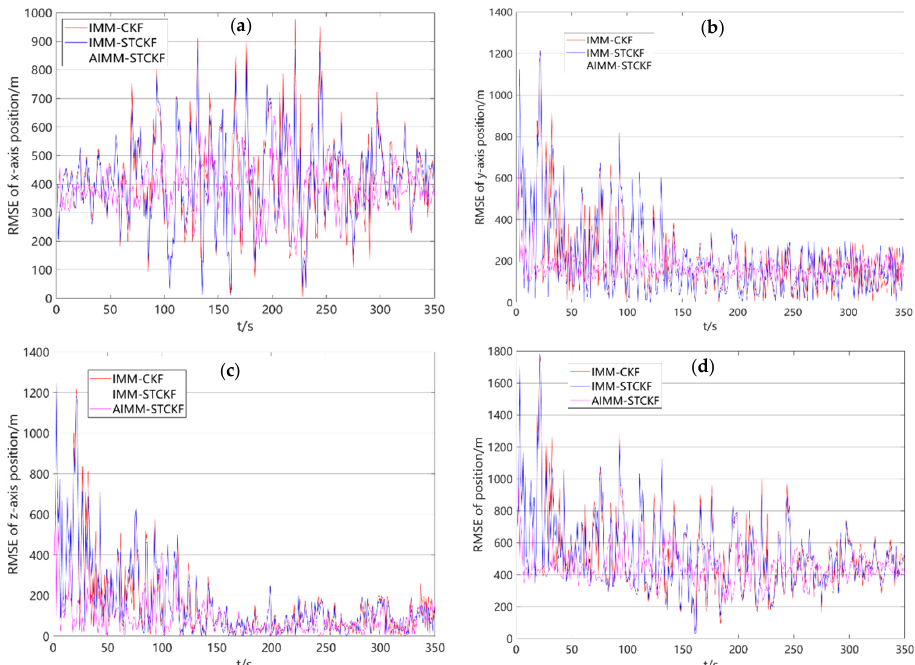
Figure 10. Position RMSE of three algorithms: ( a ) RMSE of position in the x-axis direction; ( b ) RMSE of position in the y-axis direction; ( c ) RMSE of position in the z-axis direction; ( d ) RMSE of position.